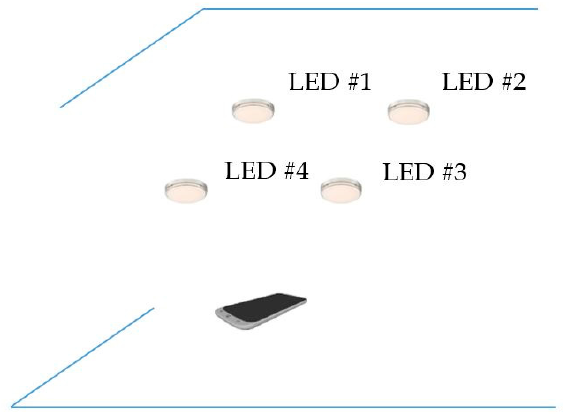
Figure 30. Localization estimation scenario.